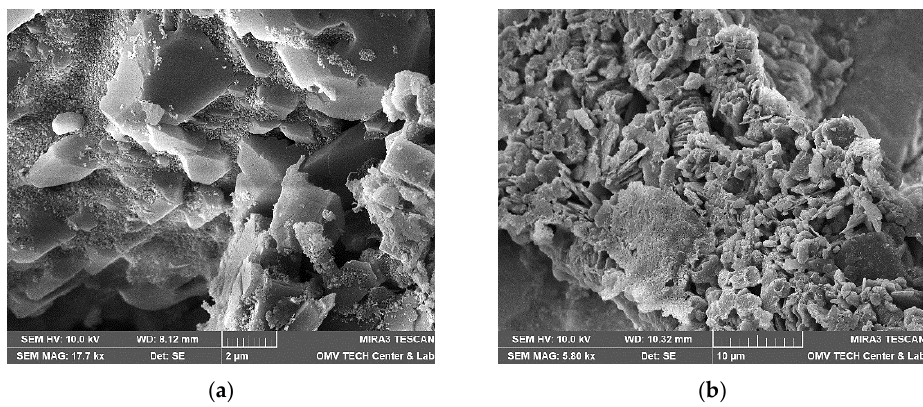
Figure 16. Scanning electron microscope (SEM) images measured for the core material used in this work. In ( a ), nanomaterials can be observed on almost all surfaces of minerals. The only exception is quartz cement with its distinctive smooth faces (Vacuum saturation of 1 wt% NF A in formation water; Berea). In ( b ), this overview shows various clay minerals that are coated completely with a layer of nanomaterials (Vacuum saturation of 1 wt% NF B in FW; Keuper).